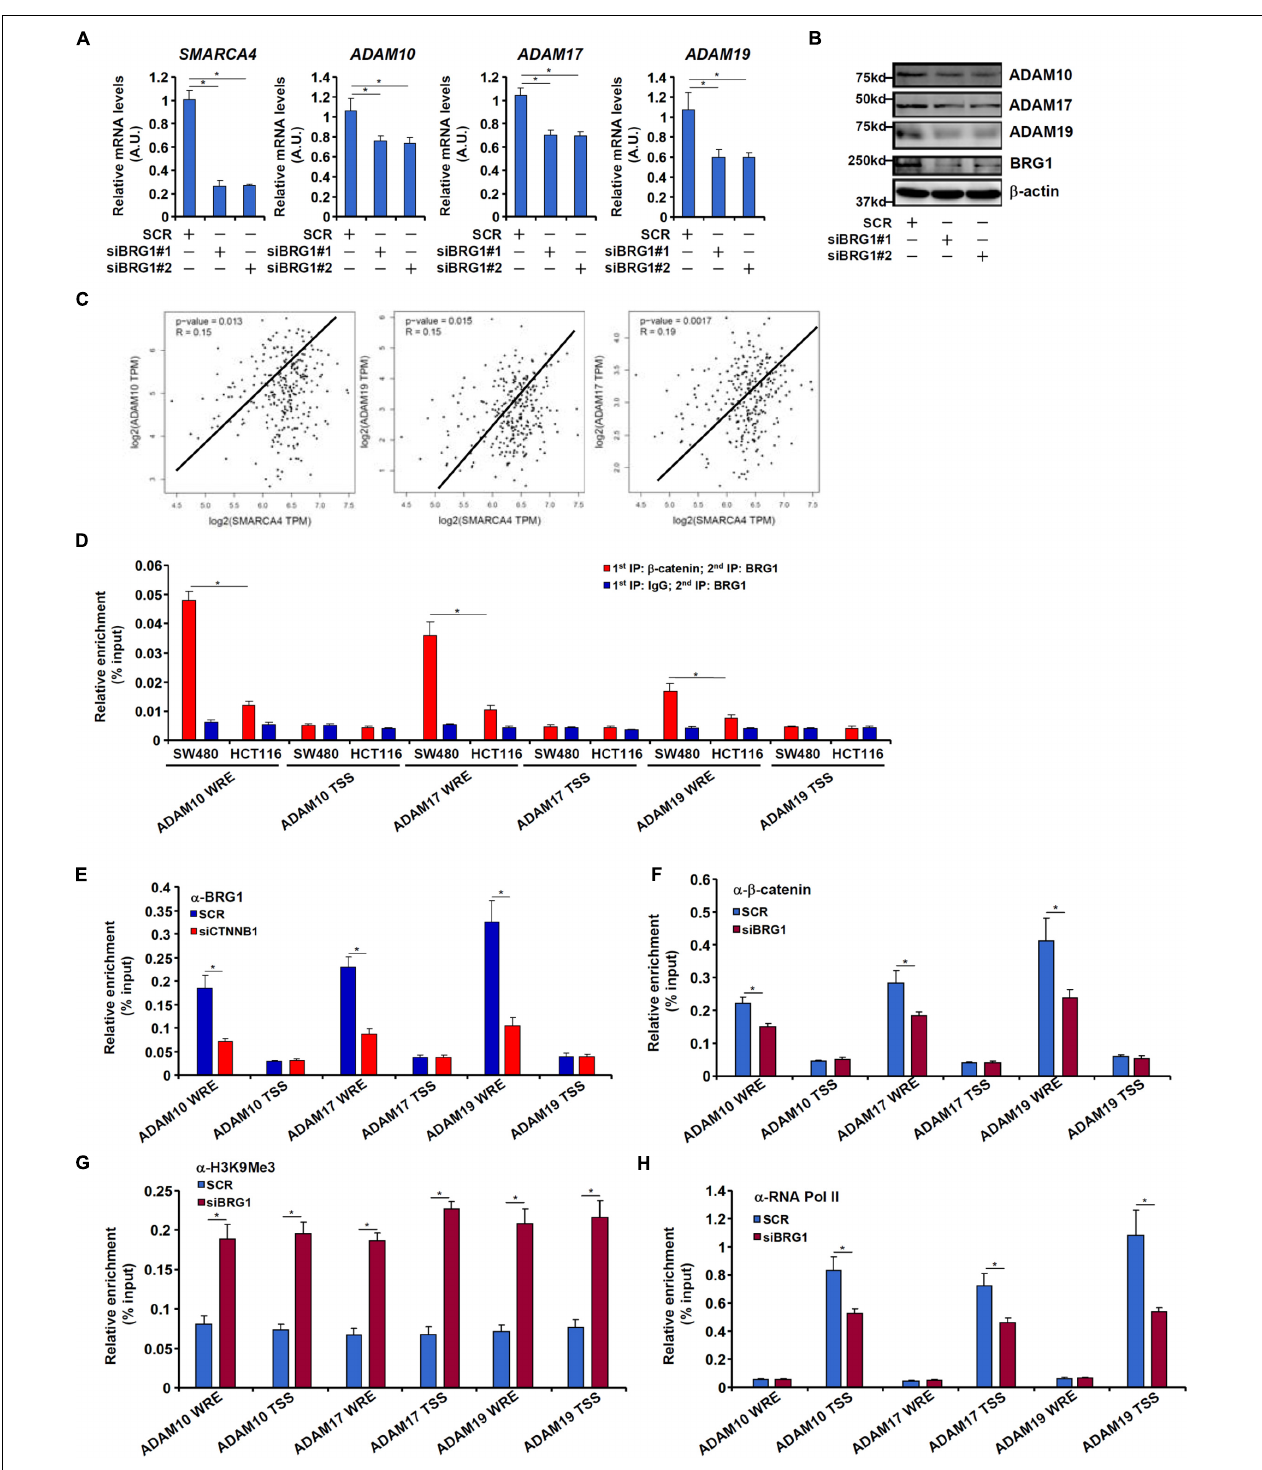
FIGURE 5 | BRG1 regulates ADAM transcription by modulating β -catenin activity. (A,B) SW480 cells were transfected with siRNA targeting BRG1 or scrambled siRNA (SCR). ADAM expression was examined by qPCR and Western. (C) Correlation between BRG1 expression and ADAM10/17/19 expression in human colorectal cancer specimens. (D) Re-ChIP assay was performed with indicated antibodies in SW480 cells and HCT116 cells. (E) SW480 cells were transfected with siRNA targeting β -catenin or scrambled siRNA (SCR). ChIP assay was performed with anti-BRG1. (F–H) SW480 cells were transfected with siRNA targeting BRG1 or scrambled siRNA (SCR). ChIP assays were performed with anti– β -catenin (F) , anti-H3K9Me3 (G) , and anti-RNA polymerase II (H) . Data represent averages of three independent experiments, and error bars represent SEM ( p < 0.05, two-tailed Student t test).